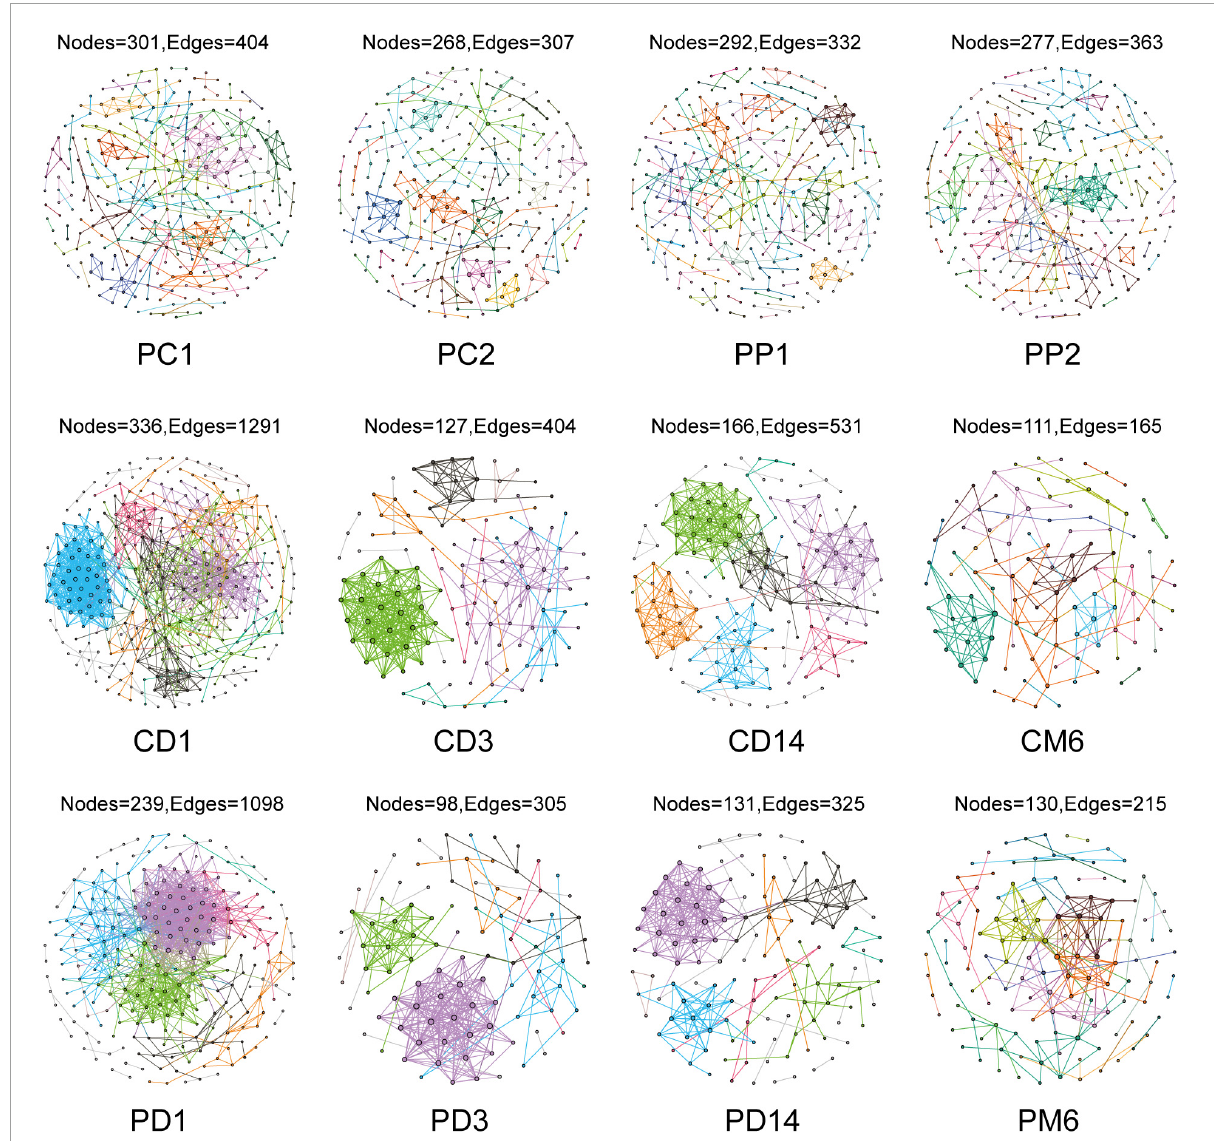
FIGURE2 Overview of the networks in pregnant women and infants. Each node represents one OTU, edges indicate significant correlations between OTUs. Different color represents different modules. PC1 and PP1 represent feces from pregnant women in the control group and the probiotic group at the first sampling time, respectively; PC2 and PP2 represent feces from pregnant women in the control group and the probiotic group at the second sampling time CD1, CD3, CD14, and CM6 represent feces from infants in the control group at day 1, 3, 14, and month 6 after birth, respectively; PD1, PD3, PD14, and PM6 represent feces from infants in the probiotic group at day 1, 3, 14, and month 6 after birth,